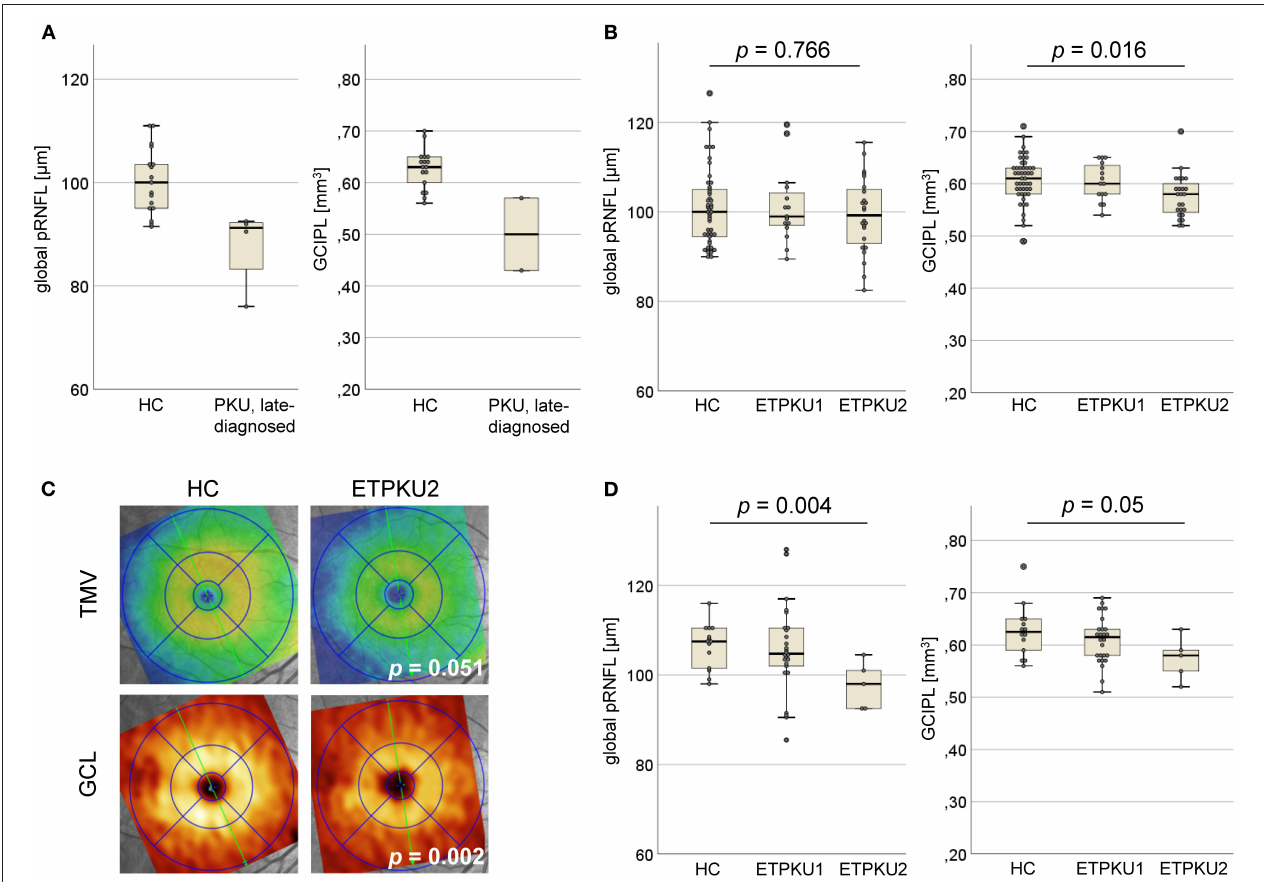
FIGURE 1 | Axonal and neuronal degeneration in phenylketonuria (PKU). (A) Global peripapillary retinal nerve fiber layer (pRNFL) thickness and ganglion cell and inner plexiform layer (GCIPL) volume in the late-diagnosed PKU patients compared with HCs ( N = 42). (B) Global pRNFL thickness and GCIPL volume in early treated phenylketonuria (ETPKU) ≥ 18 years of age compared with HCs ( N = 49). Based on average of yearly median phenylalanine levels (IDC) (as shown in Table 1 ) in childhood, adolescence, and adulthood, the metabolic control of patients was analyzed and ETPKU were grouped according to adherence to European Union (EU) guidelines (ETPKU1; IDC in childhood < 360 and < 600 µ mol/L after that, N = 15, ETPKU2; IDC in childhood > 360 µ mol/L and/or > 600 µ mol/L after that, N = 24). (C) Total macular volume (TMV) and ganglion cell layer (GCL) volume in ETPKU2 ≥ 18 years of age. Depicted is the heat map of the examination of a single patient with ETPKU2 and the corresponding HC, with a coding for TMV (blue tones; low volume, yellow/red tones; high volume) and GCL (brown tones; low volume, yellow tones; high volume). (D) Global pRNFL thickness and GCIPL volume in HCs ( N = 14), ETPKU1 ( N = 26), and ETPKU2 ( N = 5) from 6 to 17 years of age. The p -values are given for comparisons between the ETPKU2 cohort and